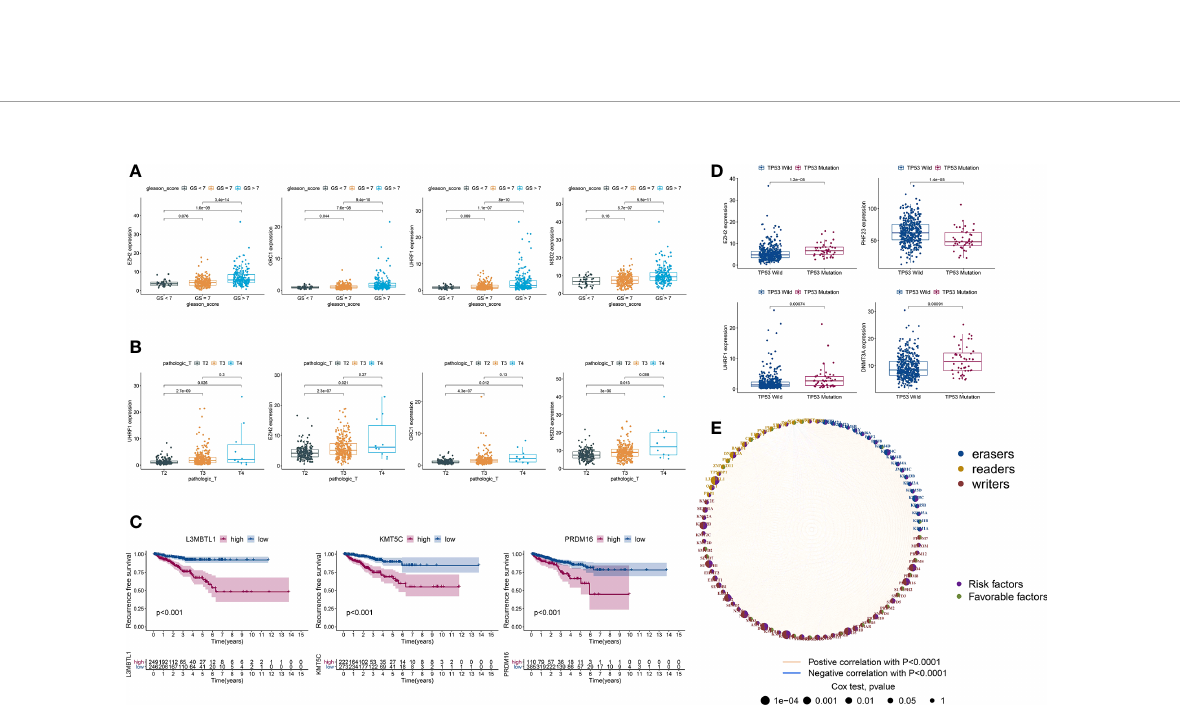
FIGURE 3 DEGs of HLM regulators in relation to different PCa clinicopathological characteristics and prognoses. (A – D) Distribution of the 3 – 4 lowest P values of HLM regulators in TCGA-PRAD data strati fi ed by GS (GS > 7 vs. GS < 7) (A) , pT (T3 vs. T2) (B) , RFS (lowest log-rank P value in the Kaplan ‒ Meier analysis) (C) , and TP53 (mutation vs. wild type) (D) . The boxplots show the median ± interquartile range values, and P values are presented above each pair of comparisons. (E) Prognostic network of interactions among HLM regulators in PCa. Different circle sizes represent the P values of each HLM regulator with respect to the prognosis. Right hemisphere of purple, risk factors for RFS; green, favorable factors for RFS. Left hemisphere of blue, erasers; orange, readers; red, writers. Lines of pink, positive correlations of HLM regulators; blue, negative